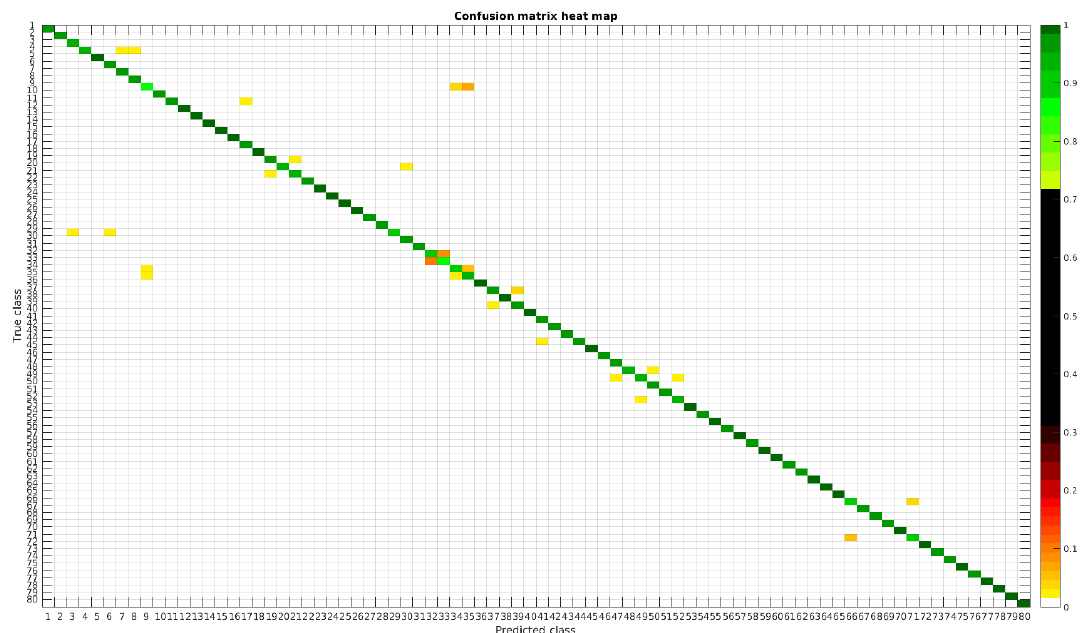
Figure 19. Confusion matrix heat map for the merged dataset with 700 samples per class.